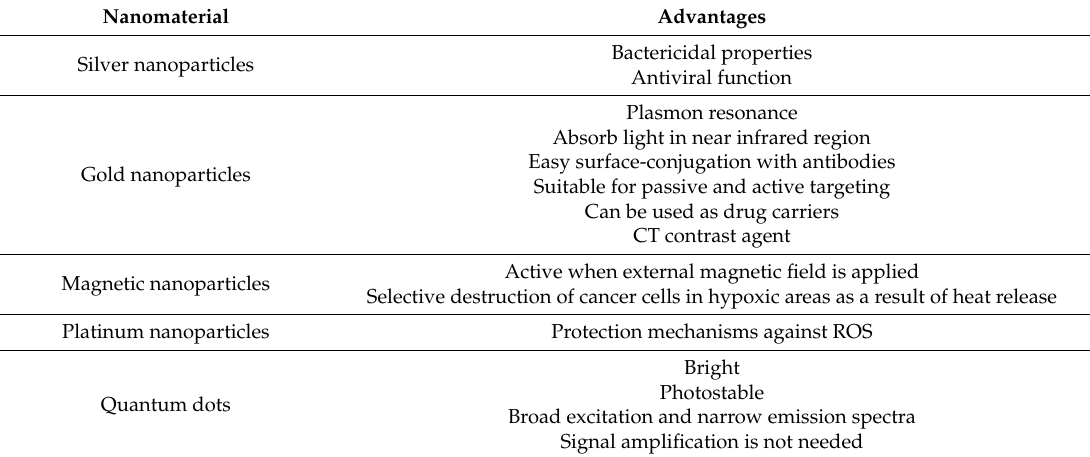
Figure 1. Schematic representation of the structures of different nanoparticles: organic (liposomes, micelles, dendrimers and polymers), metallic (gold, silver and iron nanoparticles, and quantum dots) and biological (nanobodies and extracellular vesicles–exosomes). The image is for graphical illustration only and does not represent actual sizes or size ratios among particles. Table 1. Summary of the advantages of nanomaterials.